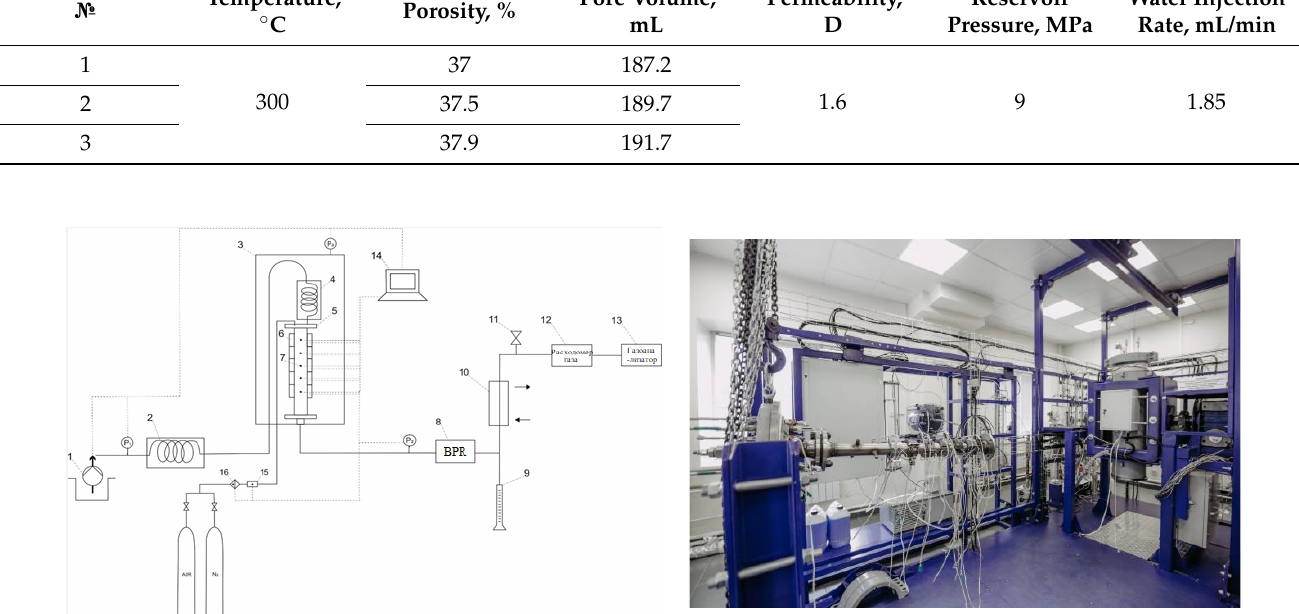
Figure 8. Schematic and photo of a unique scientific facility for physical and chemical modeling of the process of in-situ combustion and steam-gravity drainage.